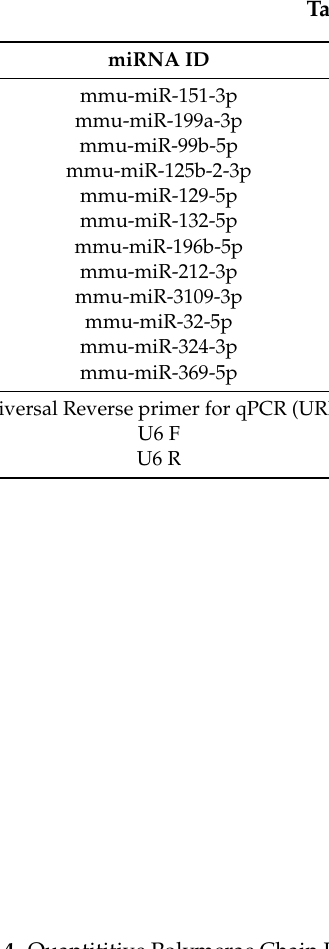
Figure 4. Quantititive Polymerae Chain Reaction (qPCR) verification of the enrichment level of the stably enriched di ff erential exosomal miRNAs (DEmiRs). Stem-loop Reverse Transcription- quantititive Polymerase Chain Reaction (RT-qPCR) was performed to compare the relative enrichment level of the candidate miRNAs normalized with the internal control U6 small nucleic RNA (snRNA) level, between the exosomes from group A ( Tg -DC-EXO) and group B (DC-EXO). The enrichment level of each DEmiR from group B (the grey column) was set as 1. The height of the black columns represented the folds of the enrichment level of the indicated miRNAs from group A being divided by the level form group B. The p-value was calculated by the SPSS software. *** p -value < 0.005. X: miRNA ID. Y: Fold change.